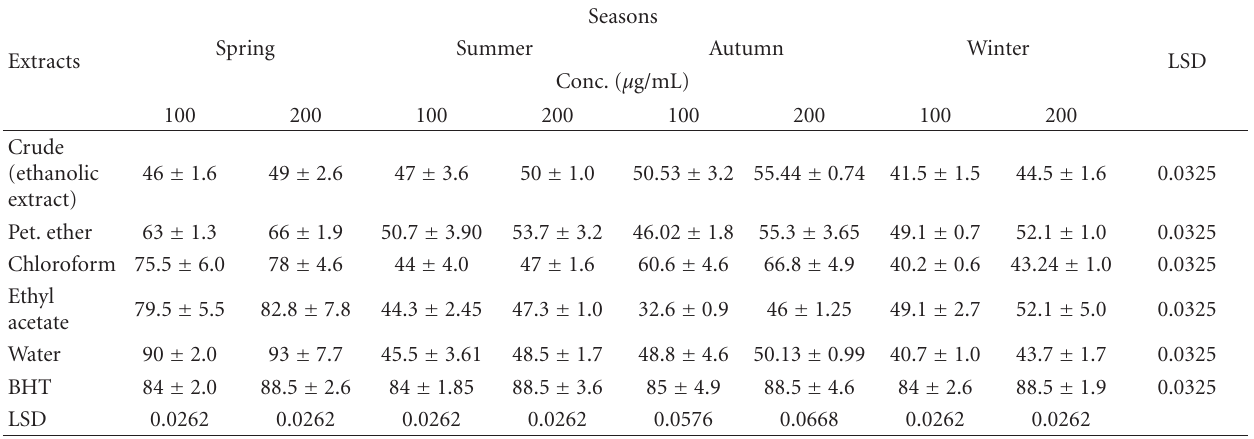
Table 3: Antioxidant activity (%) of di ff erent extracts from Enteromorpha compressa using DPPH method after 30min at 100 and 200 μ g/mL.